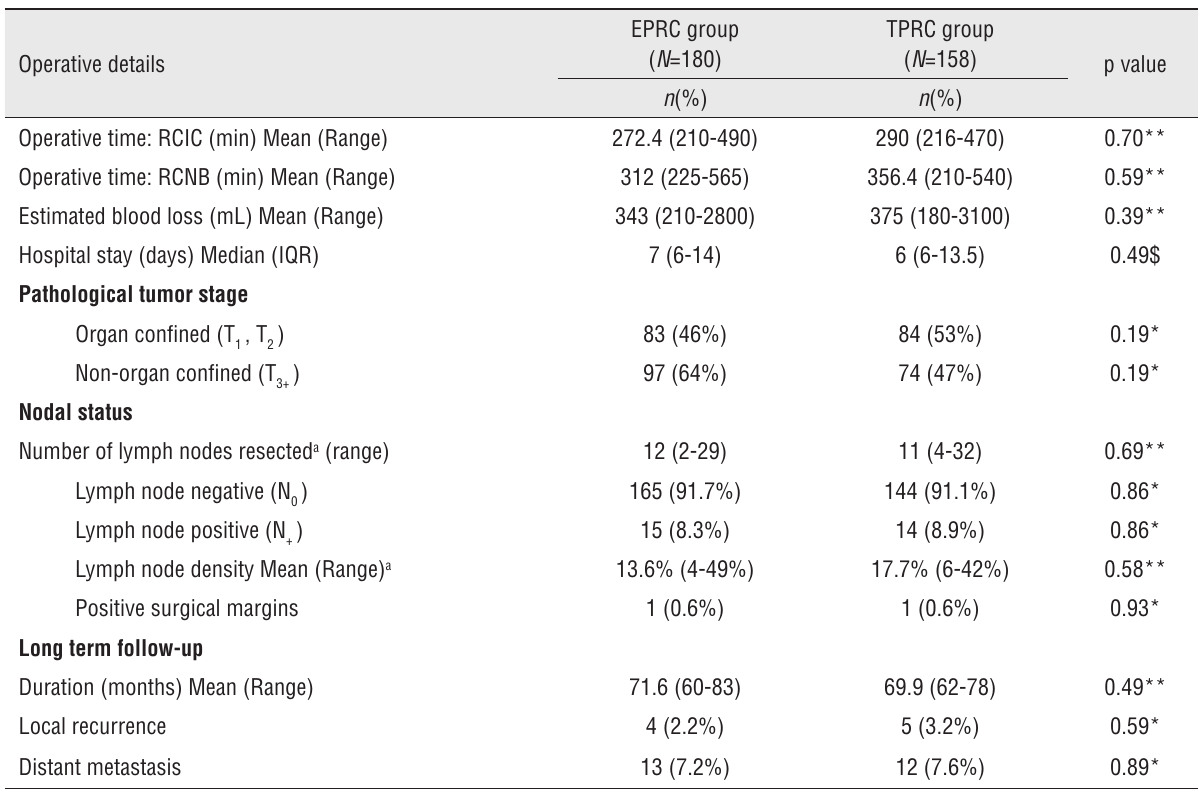
Table 2 - Patients’ operative and follow up